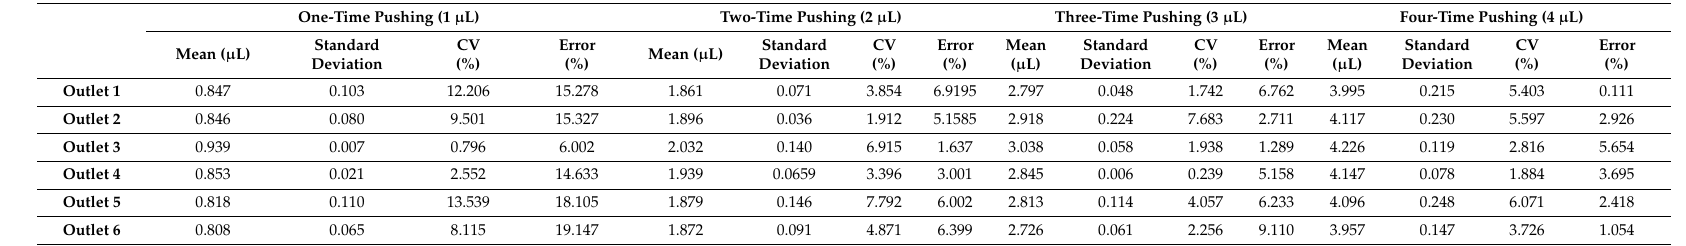
Table 1. Statistical analysis regarding the dispensed volume from each outlet with respect to the number of the pushing